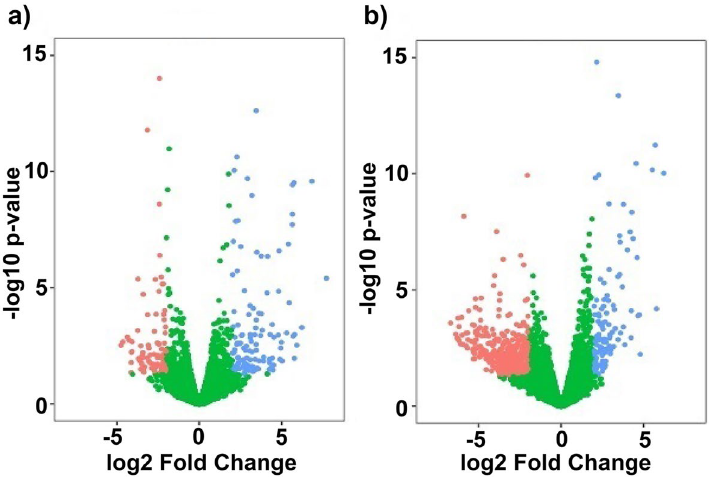
Figure 1. Volcano Plot Showing the Distribution of DEGs. The fold of change (log2) and p value (− log10) of genes from ( a ) 16 h DEX treatment (Group A), ( b ) 7 d DEX treatment (Group B) are